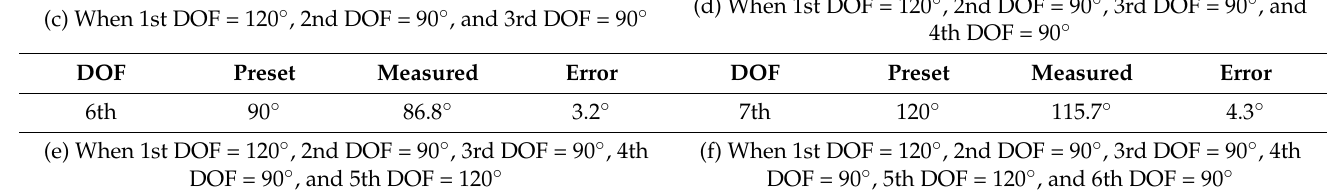
Table 3. Motion measurement based on coupling analysis.